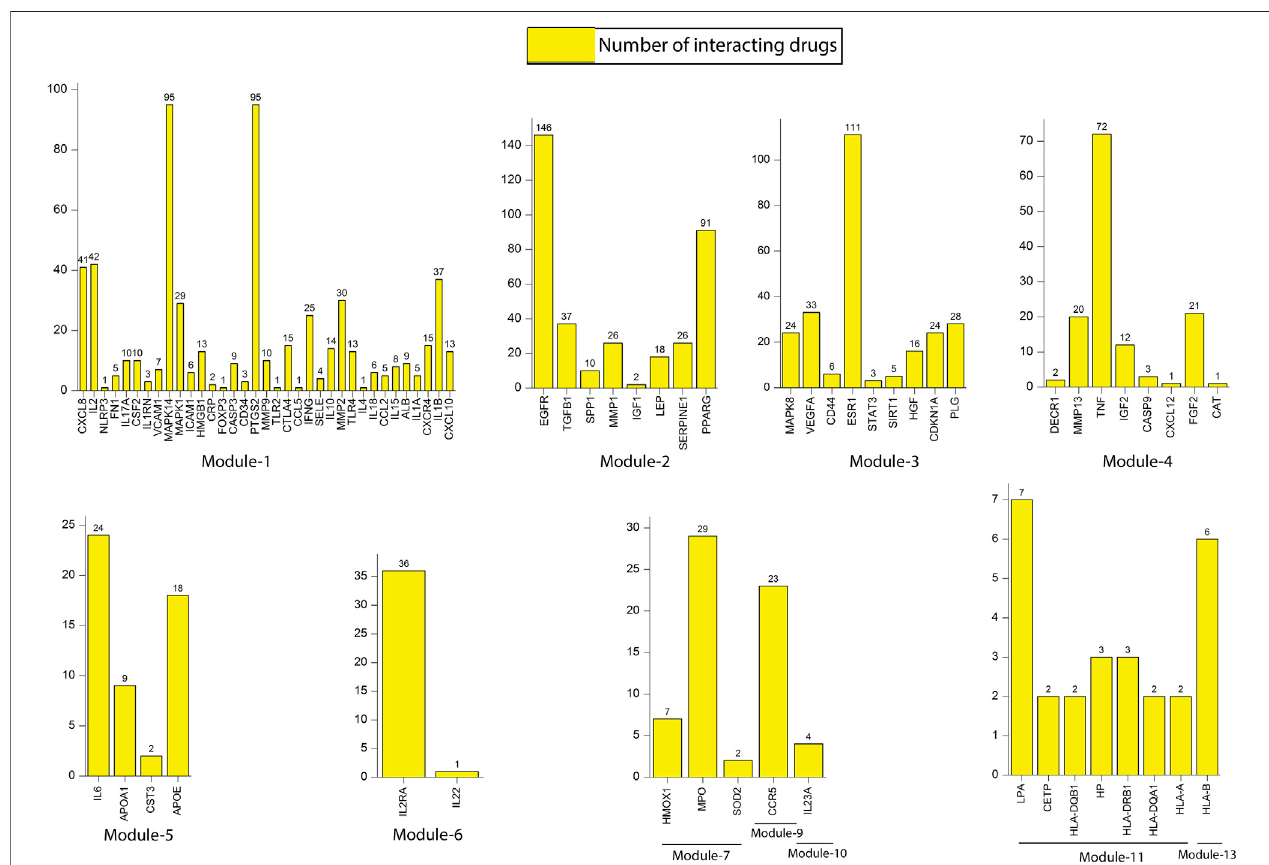
FIGURE 9 | Representation of the number of interacting drugs with key